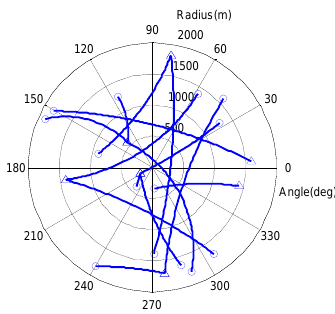
Figure 3. Target trajectories in polar coordinates with start and stop positions denoted by △ and ○ .